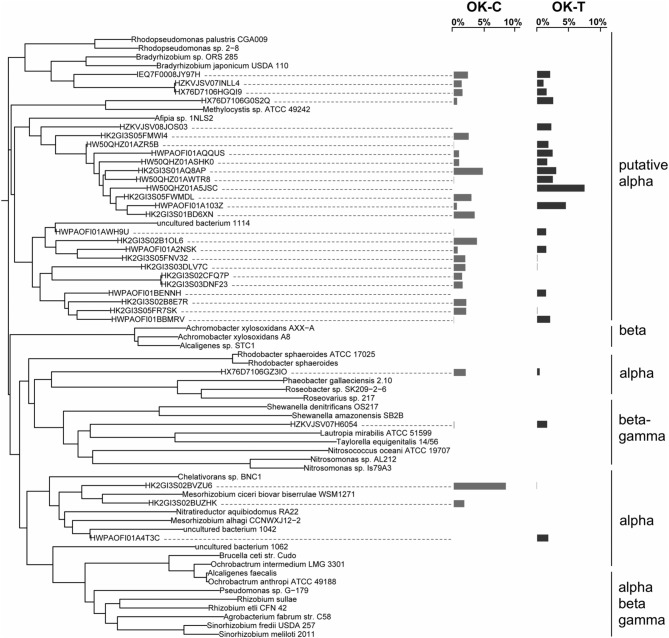
NirK neighbor-joining tree based on amino acid sequences showing the most abundant 32 OTU representative sequences comparing Oklahoma control (OK-C) to warming (OK-T) samples with reference sequences. The OTUs shown contain 48.3% of sequences in OK-C and 43.4% of the sequences in OK-T. The average relative abundances are represented by bar graphs to the right of the OTU. The first column corresponds to OK-C, the second to OK-T.